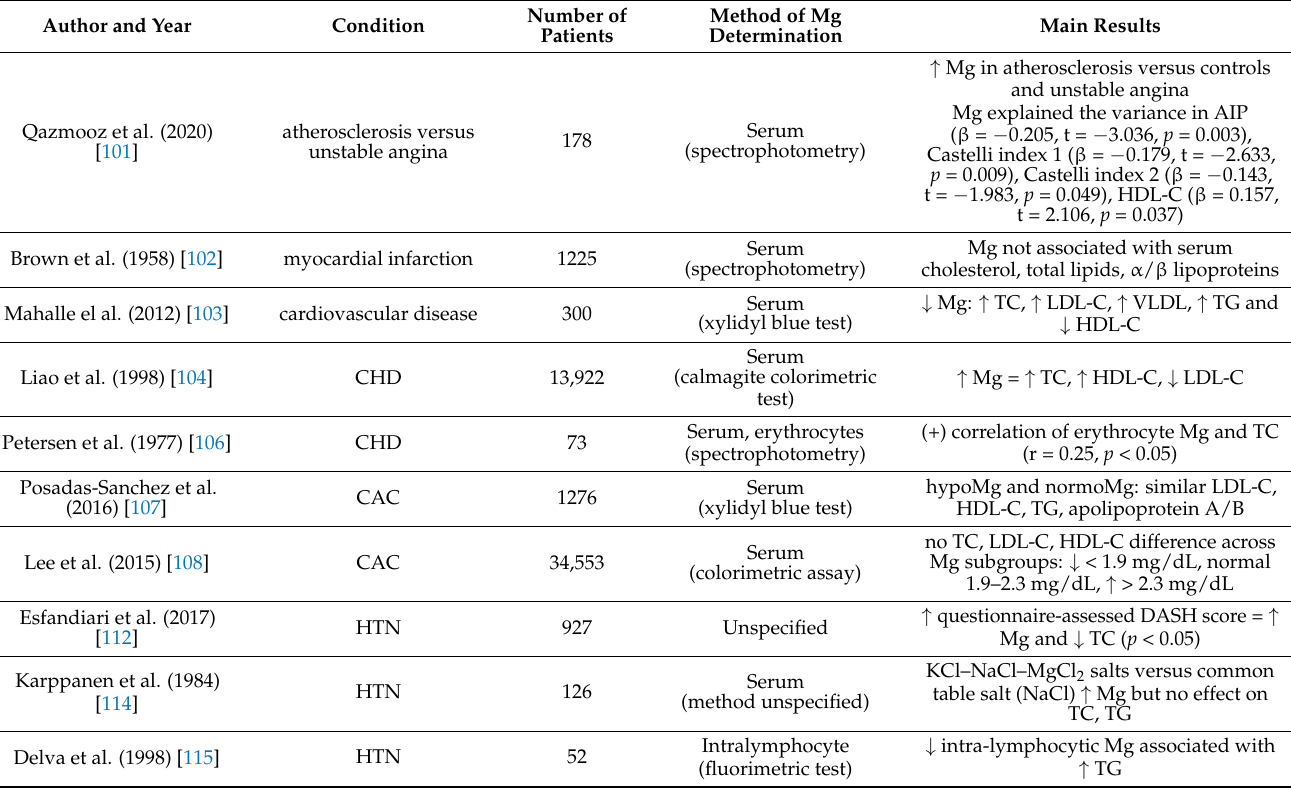
Table 5. Interplay of magnesium and serum lipids in cardiovascular